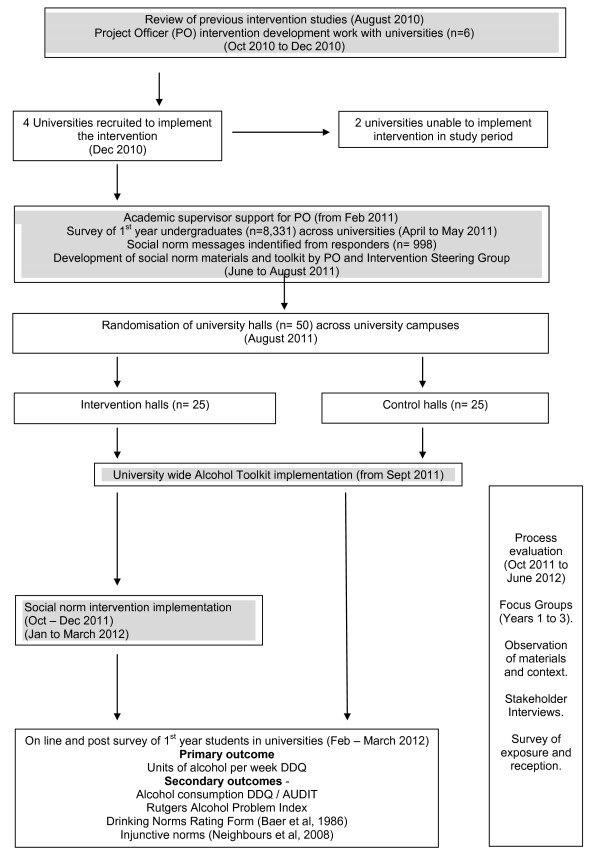
Research design.